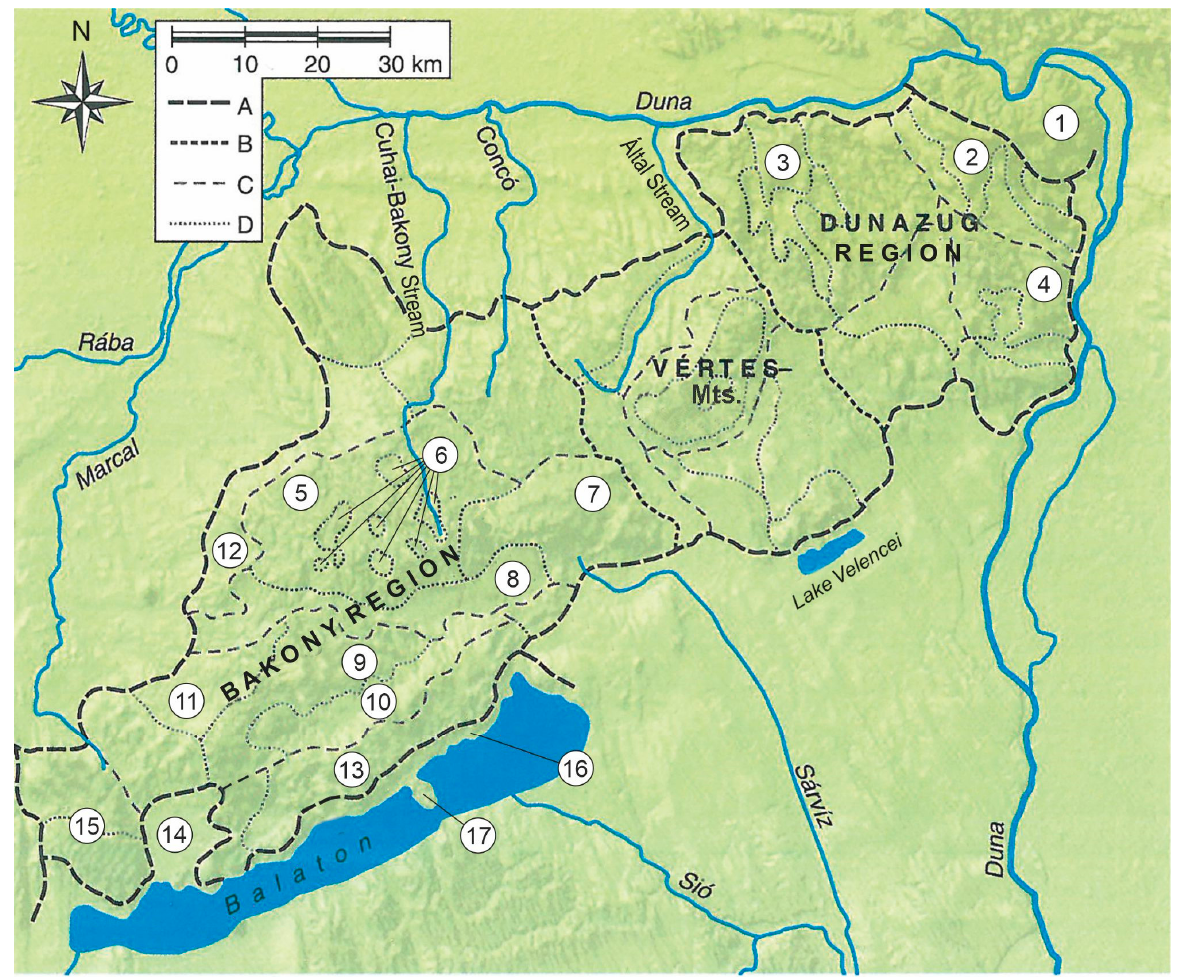
Figure 1. Parts of the Transdanubian Mountains [8]. Legend: 1. Visegrád Mountains, 2. Pilis Moun- tains, 3. Gerecse Mountains, 4. Buda Hills, 5. Old Bakony, 6. Small basins of Bakony, 7. Tés Plateau (Northern Bakony), 8. Veszprém–Devecser graben, 9. Kab Mountain–Agártet ő group, 10. Veszprém–Nagyvázsony basin, 11. Sümeg–Tapolca ridge, 12. Devecser–Bakonyalja (Southern Ba- kony), 13. Balaton Uplands, 14. Tapolca Basin, 15. Keszthely Mountains, 16. Balatoni–Riviera, 17. Tihany Peninsula. A. boundary of macro region, B. boundary of meso region, C. boundary of micro region group, D. boundary of micro region.